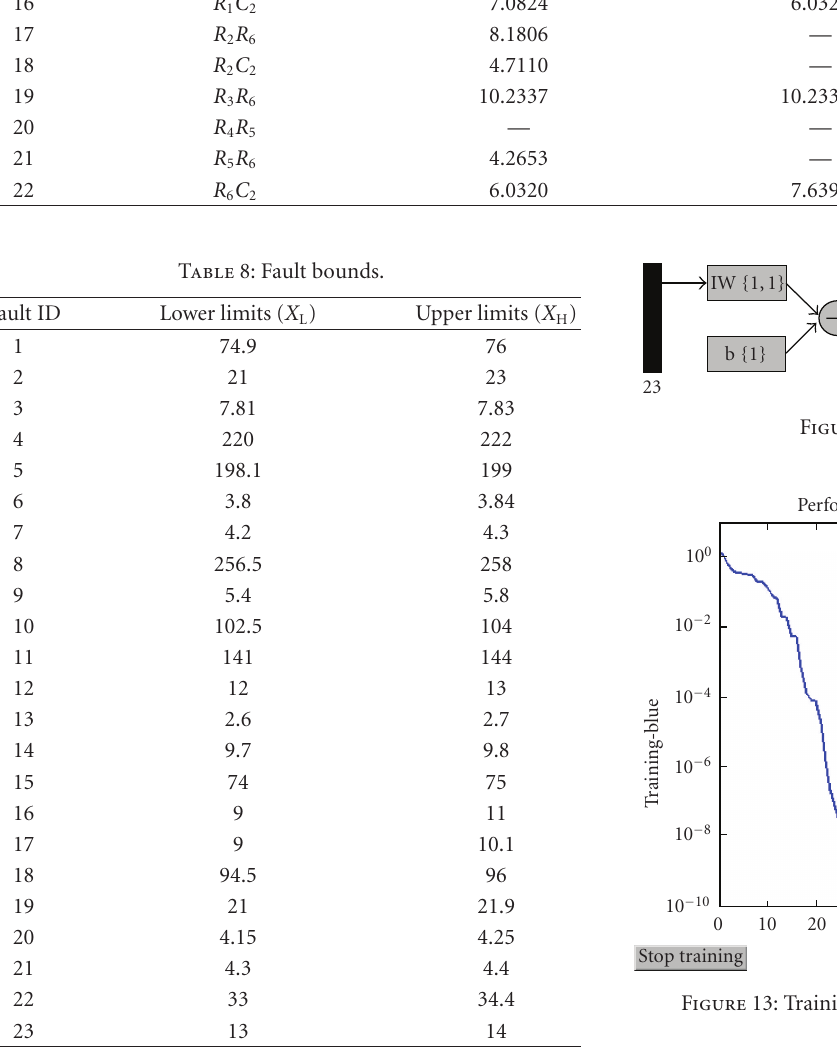
cates the input layer comprising 23 neurons, the centre block indicates the middle layer comprising 10 neurons and the last block indicating the output layer comprising 5 neurons, respectively. The blocks in between the input layer and the middle layer indicate the weight factor (IW { 1,1 } ) associ- ated with input node, and bias input (b { 1 } ) acts on a neuron like an o ff set. The blocks in between the middle layer and the output layer indicate the weight factor (LW { 2,1 } ) associated with middle layer, and bias input (b { 2 } ) acts on a neuron like an o ff set. For few randomly generated test patterns for the filter cir- cuit, classifier results are shown in Table 9. The results agree well within the corresponding fault